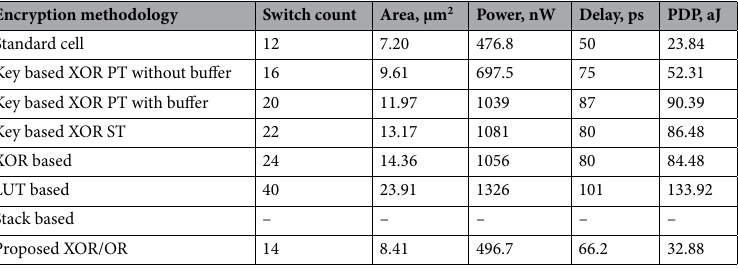
Table 15. Results comparison for XOR